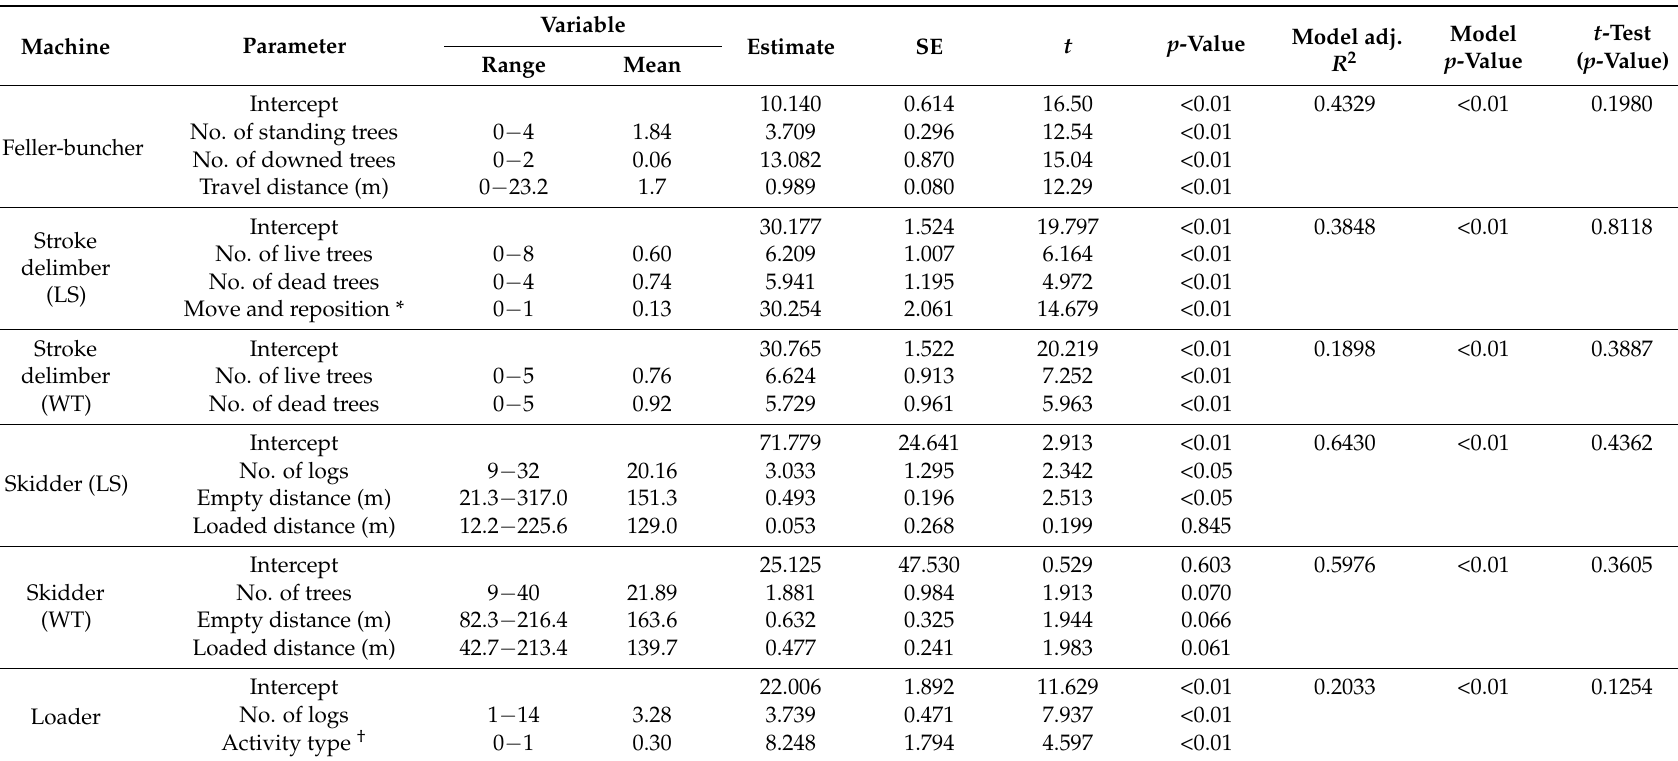
Table 6. Delay-free cycle time regression models for feller-buncher, delimber, skidder, and grapple loader used in lop and scatter (LS) and whole-tree harvesting (WT). Cycle times are in seconds (s). A paired t -test was used for model validation against observed